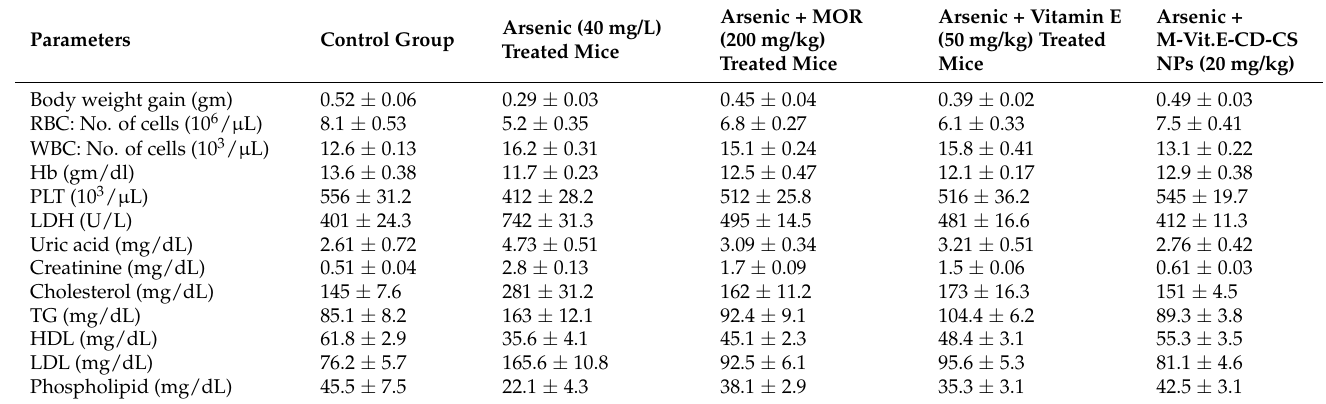
Table 1. Effect of oral administration of MOR and MCNPs on hematological parameters.